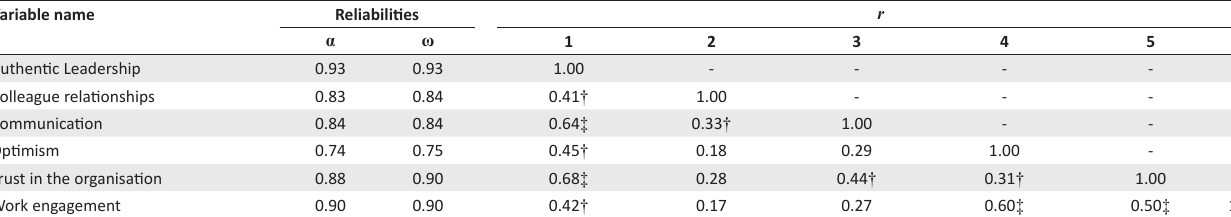
TABLE 2: Correlation matrix for the latent variables.